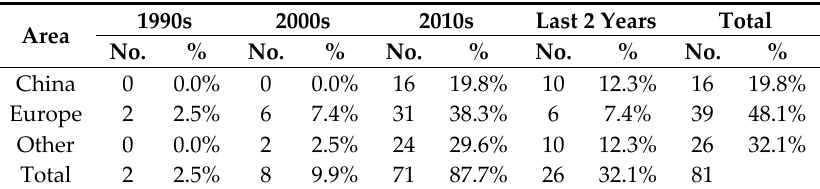
Table 2. Geographical Area of Research.